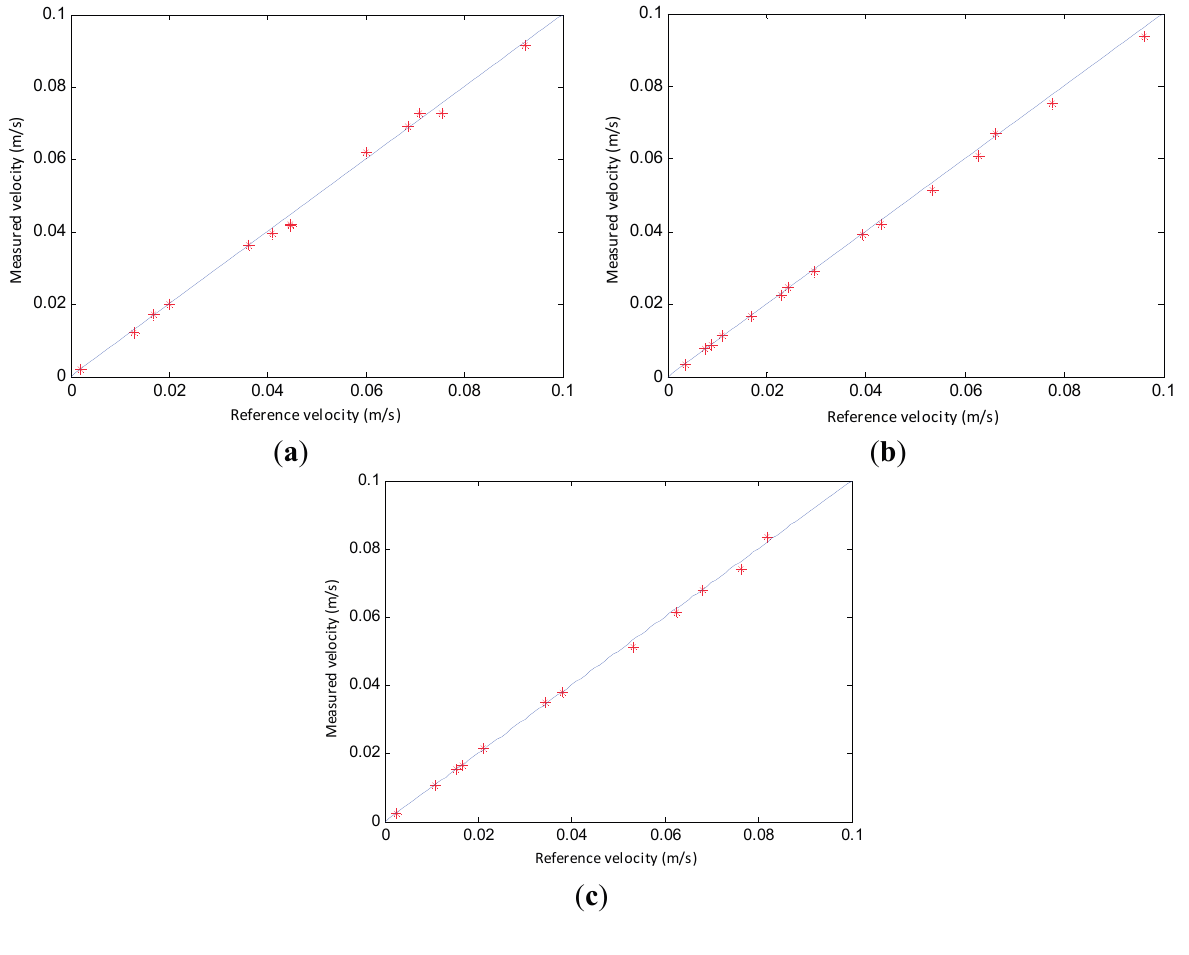
Figure 12. Comparison between the measured and reference velocities: ( a ) Experimental results with 1.56 mm inner diameter pipe; ( b ) Experimental results with 2.65 mm inner diameter pipe; ( c ) Experimental results with 3.96 mm inner diameter